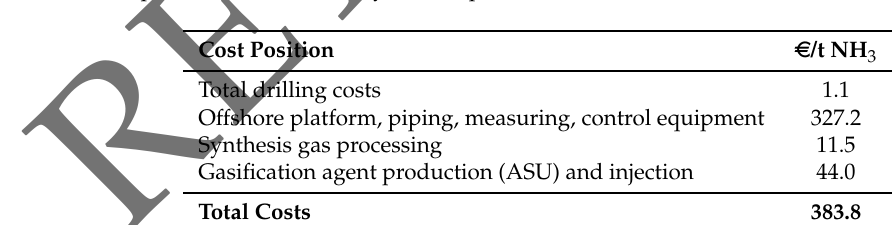
Table 16. Individual components of levelized offshore Underground Coal Gasification (UCG) based ammonia production costs for 20 years of